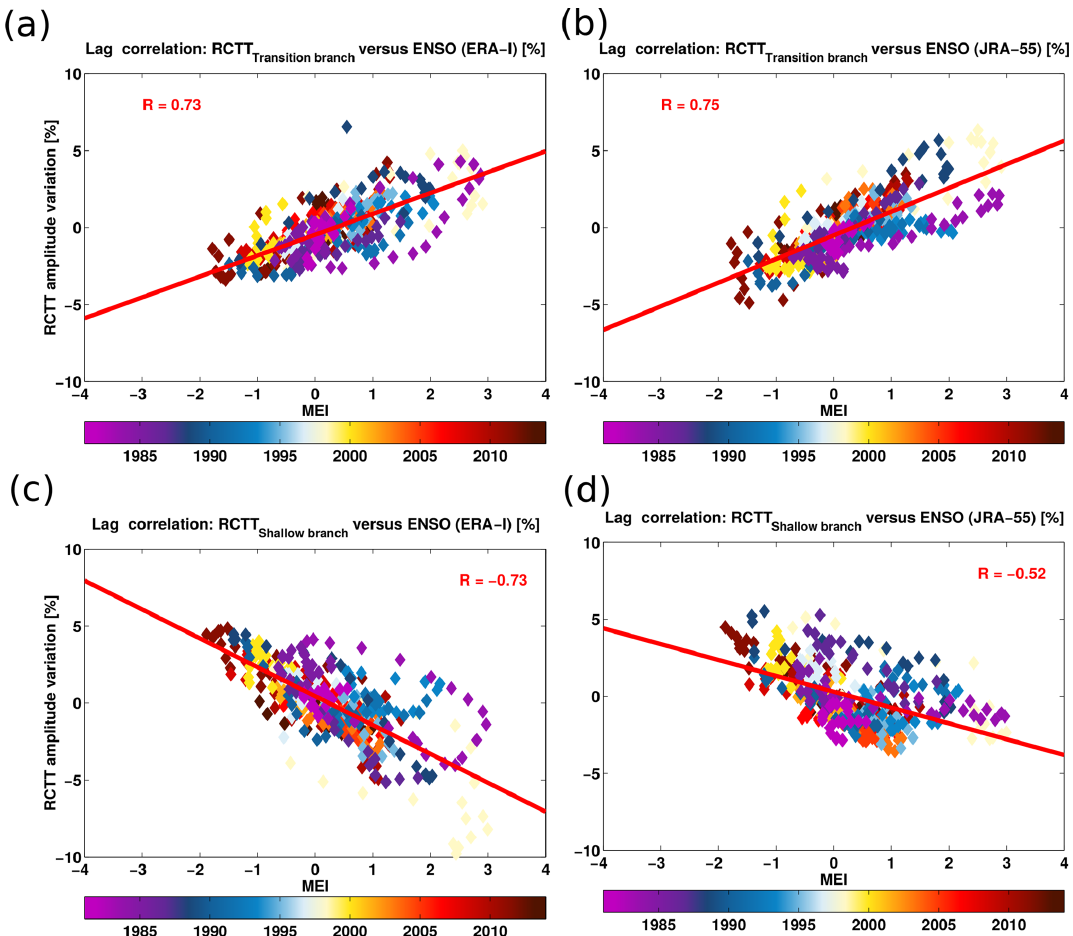
Figure 6. Lag correlation of the ENSO impact on RCTT versus the MEI from CLaMS simulations driven by ERA-I (a, c) and JRA-55 (b, d) . Transition branch (a, b) and shallow branch (c, d) changes are shown in percent change relative to the monthly zonal mean climatology. The RCTT variations attributed to the ENSO events using the regression analysis are averaged between 20 and 70 ◦ and between 370 and 420K for the transition branch and between 10 and 70 ◦ and between 420 and 500K for the shallow branch during the 1979–2013